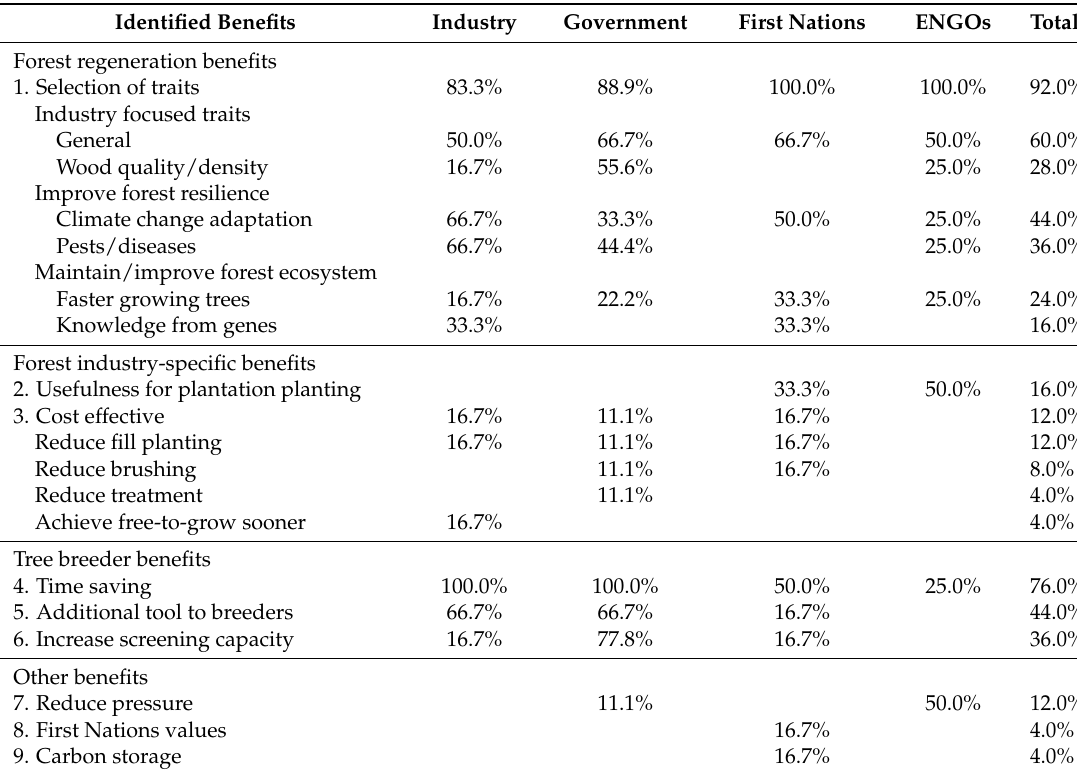
Table 5. Identified benefits of MAS, represented as the relative proportions by group and of the total sample population, calculated using relative frequencies.